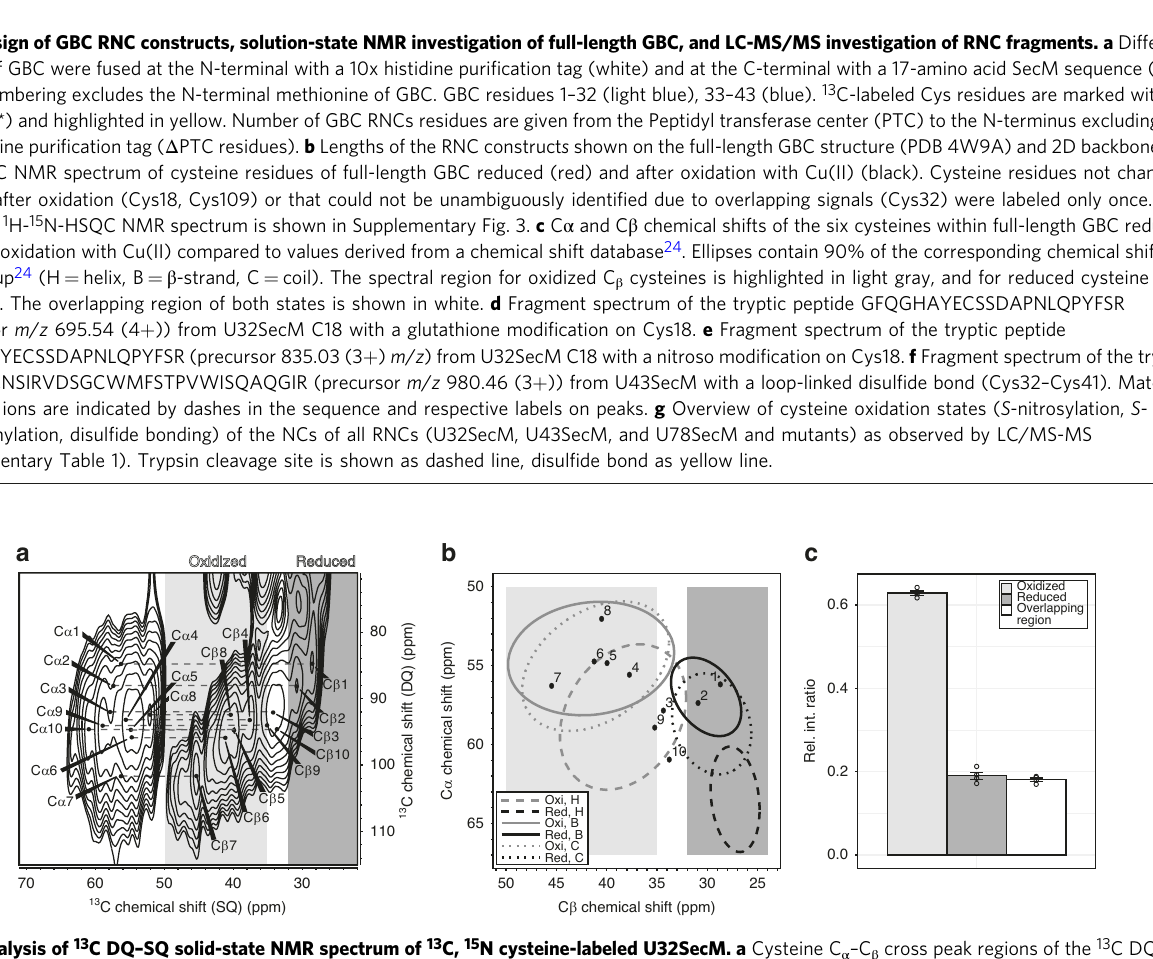
Fig. 2 Analysis of 13 C DQ – SQ solid-state NMR spectrum of 13 C, 15 N cysteine-labeled U32SecM. a Cysteine C α – C β cross peak regions of the 13 C DQ – SQ spectrum of 13 C, 15 N cysteine-labeled U32SecM cryo-EM sample (3.4 nmol). b C α and C β chemical shifts from U32SecM compared to values derived from a chemical shift database 24 (left panel). Ellipses contain 90% of the corresponding chemical shifts within each group 24 (H = helix, B = β -strand, C = coil). The spectral region for oxidized C β cysteines in light gray, and for reduced cysteine in dark gray. c Relative integration ratio (Rel. Int. Ratio) of oxidized (light gray) or reduced residues (dark gray) or the overlapping region (white), which does not allow for differentiation, of one U32SecM sample. Signal intensity of oxidized cysteine residues (>35 ppm), reduced cysteine residues (<32 ppm), and the overlapping region (35 – 32 ppm) was divided by the total signal intensity of C β chemical shifts. Error bars represent the standard error of the mean and were calculated using four different integration regions ( “ Methods ” ). Each circle represents the Rel. Int. Ratio of one individual integration can populate multiple conformations, we simulated the con- formational space of the NC within the tunnel using fl exible- meccano 26 , a method that relies on amino acid-speci fi c ( φ / ψ ) sampling in coil regions of protein structure. The dimensions of the ribosomal exit tunnel were taken from the cryo-EM structure (PDB: 6YS3), and the NC was sequentially built from Ser151 of SecM by adding 26 amino acids to the N-terminal end. Indeed, the ribosomal exit tunnel provides suf fi cient space for different disul fi de bridges to form including a disul fi de bond between Cys22 and Cys32 inside the ribosomal exit tunnel close to the constriction site (Supplementary Fig. 5). Further, we were able to observe that the ribosomal exit tunnel modulates the sampling of the NC, with Cys32 and Phe150 showing a higher propensity to sample an α -helical conformation inside the ribosomal exit tunnel of E. coli than in solution (Supplementary Fig. 6).